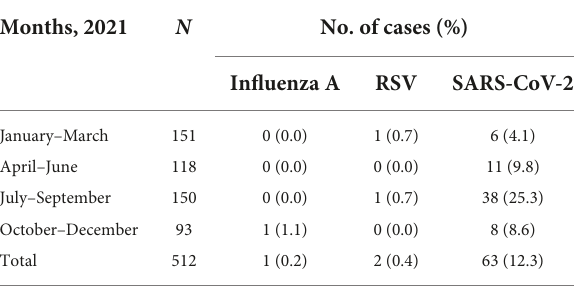
TABLE 2 Number of cases and positivity rates across